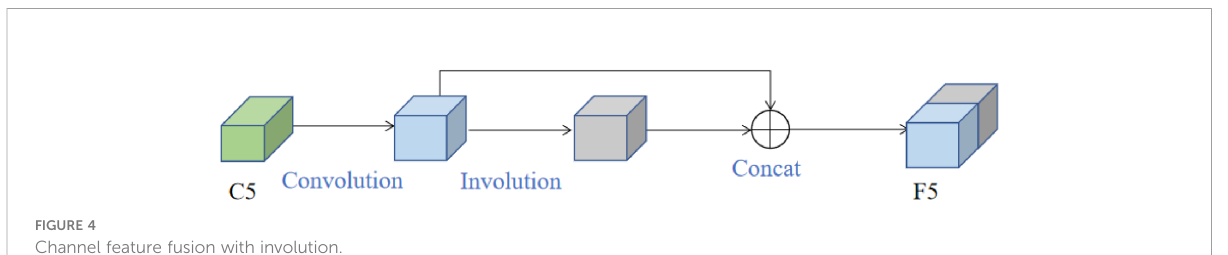
FIGURE 4 Channel feature fusion with